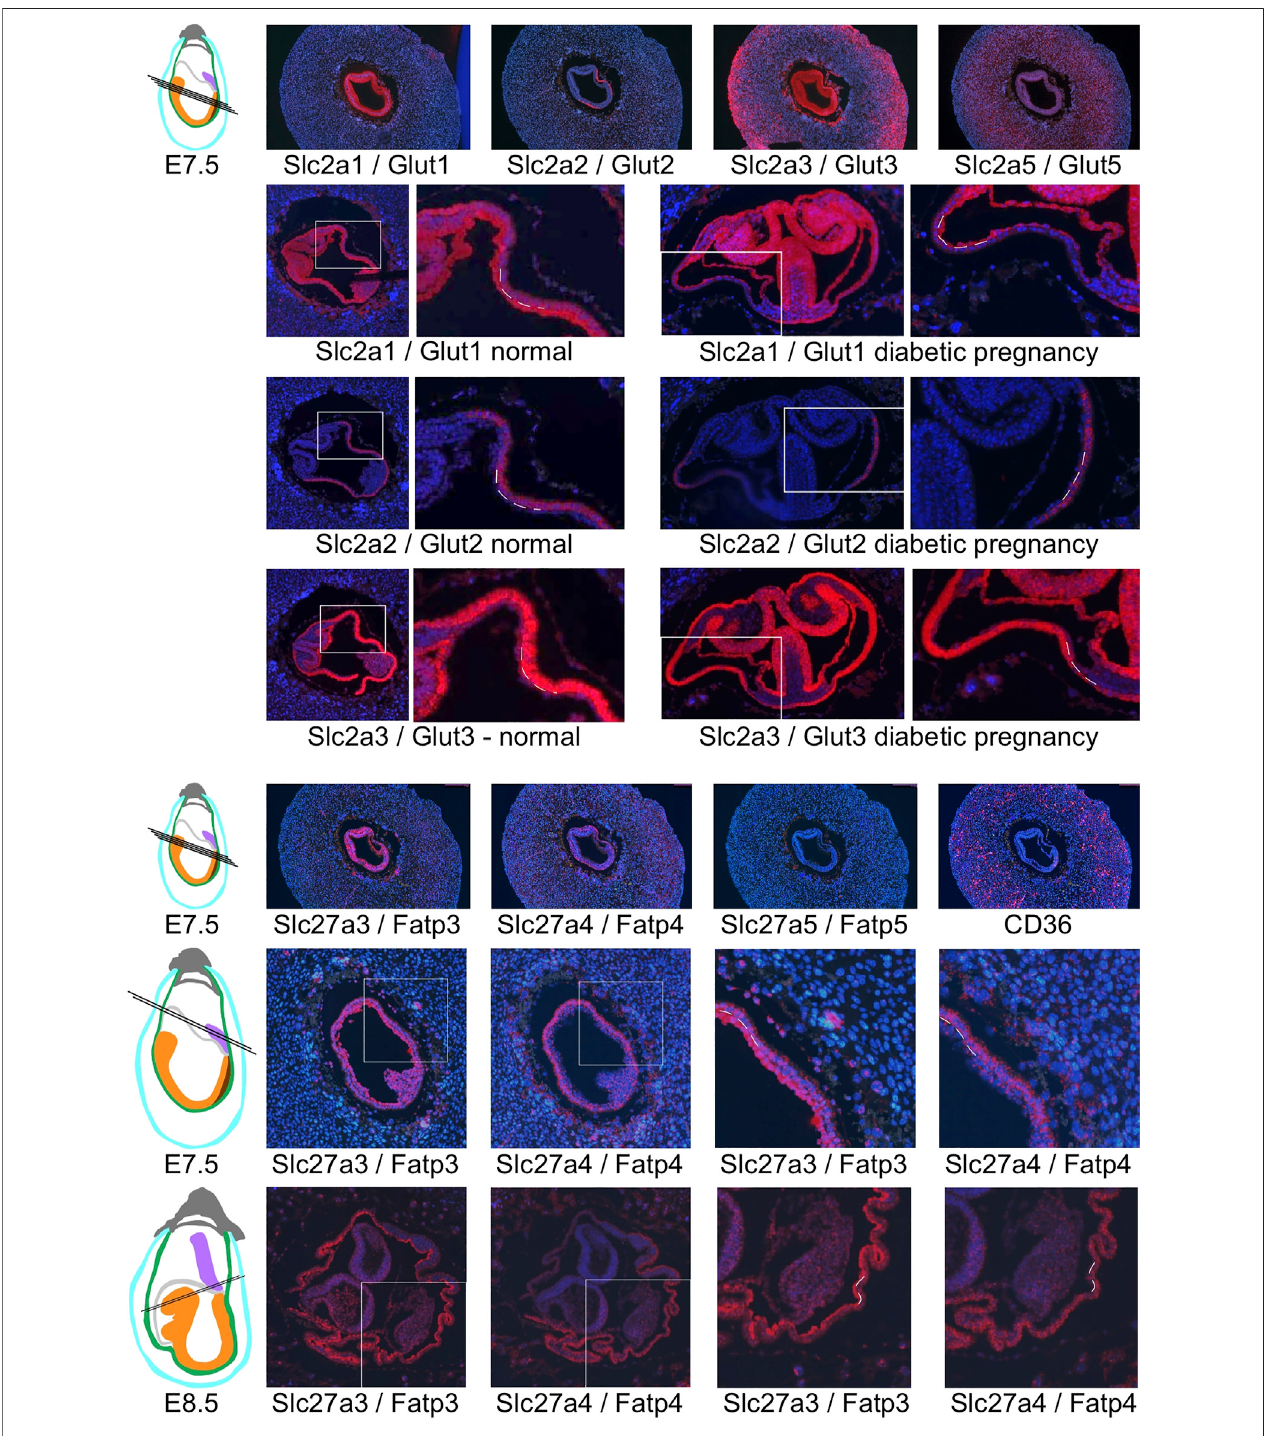
FIGURE8| Restrictedexpressionofnutrienttransportersinvisceralyolksaccells.Glucosetransporterexpressionisshownindeciduafromnormalpregnanciesat E7.5, and at E8.5 from normal and diabetic pregnancies (the same sections shown in Figure 7 ). White frames indicate the region of magni fi cation, and broken lines indicatethecelllayersofthevisceralyolksac:endodermislocatedontheoutsidetwoardstheyolksaccavity,withthemesodermallayerofthevisceralyolksacfacingthe embryo. Slc2a1/Glut1 expression is prominent in the mesodermal layer, while Slc2a3/Glut3 is expressed more strongly in the endoderm layer, and Slc2a2/Glut 2 expression is restricted tovisceralyolk sac endoderm. Ofthe fatty acidtransporters, Slc27a5/Fatp5 and CD36 werenot speci fi cally detected in visceralyolk sac at E7.5 or E8.5 (not shown), while Slc27a3/Fatp3 and Slc27a4/Fatp4 display reciprocal predominance in the mesodermal and endodermal layers of the yolk sac, respectively.